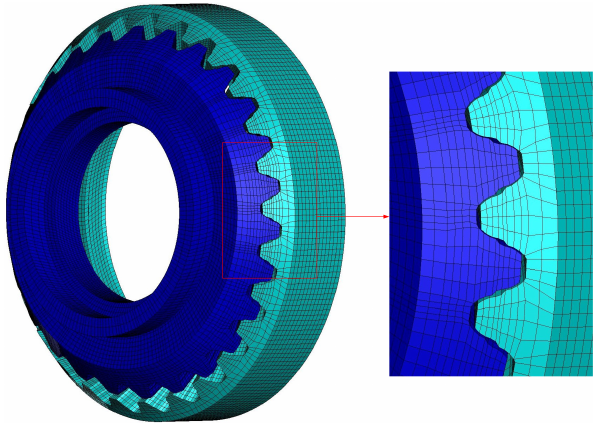
Figure 7. Finite-element dynamic analysis model.